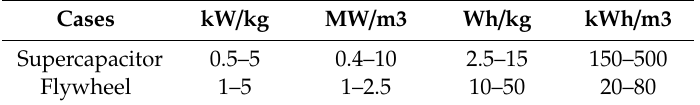
Table 3. Power and energy characteristics of flywheen ESS and supercapacitor ESS.